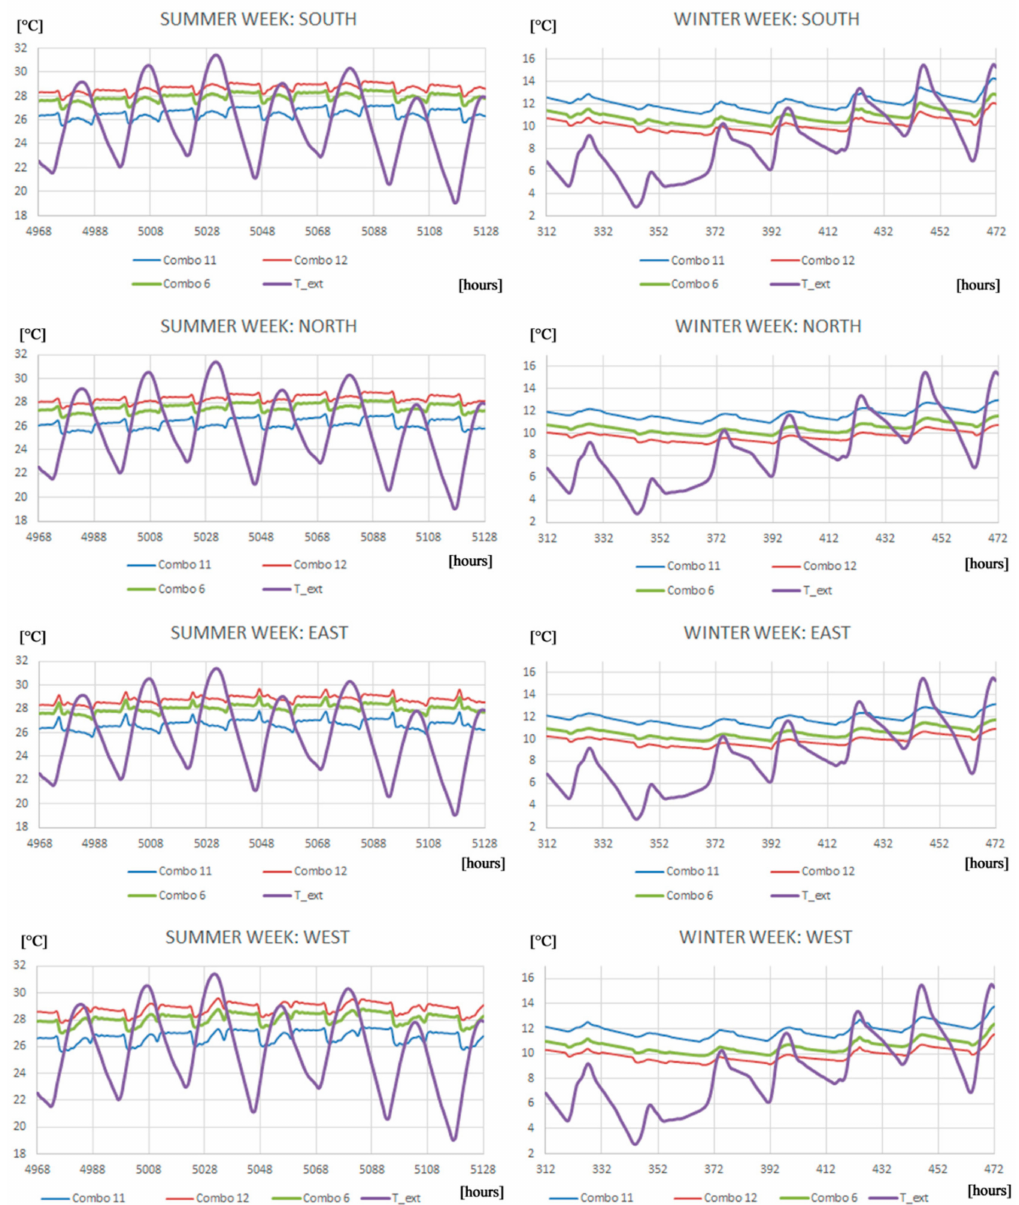
Figure 15. TOP trend for Combos 6, 11, 12, and external air temperature (27 July–2 August; 14–20